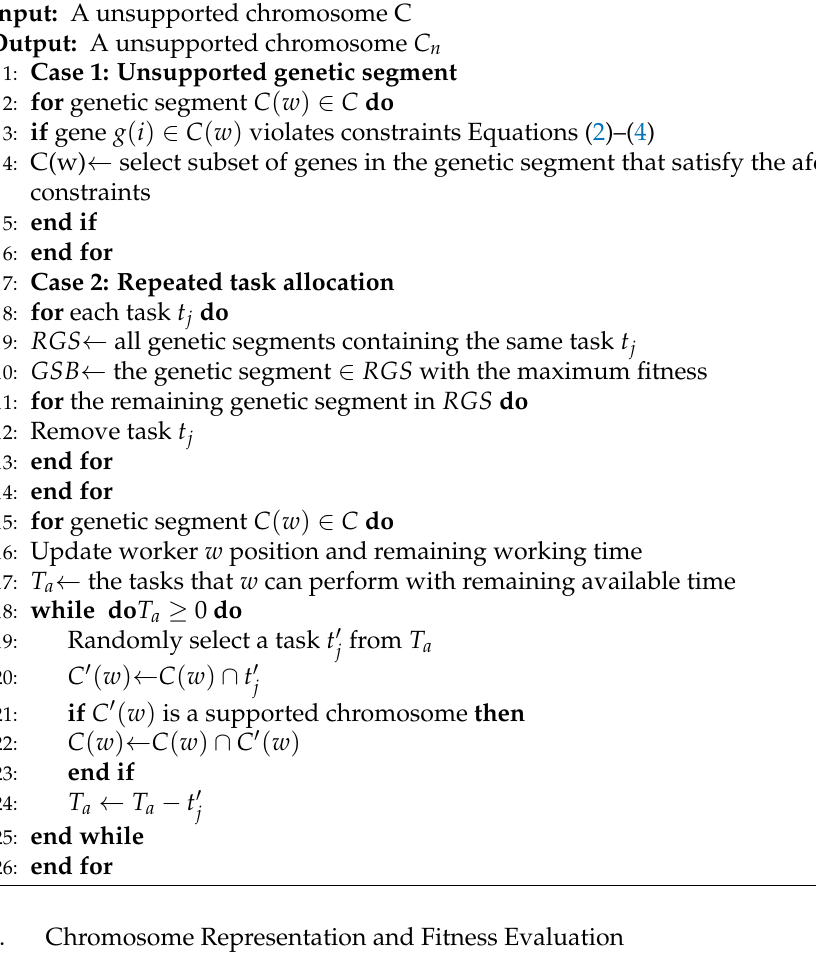
Algorithm 3 Re-establishing